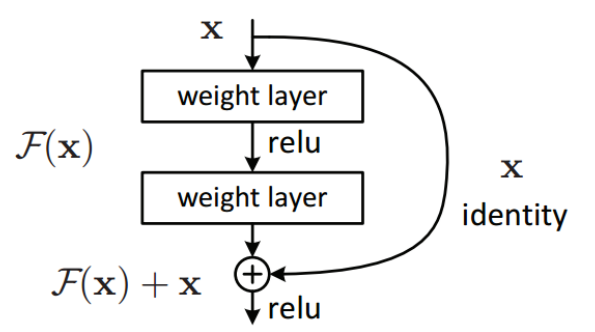
Figure 4. Multilayered perceptron.